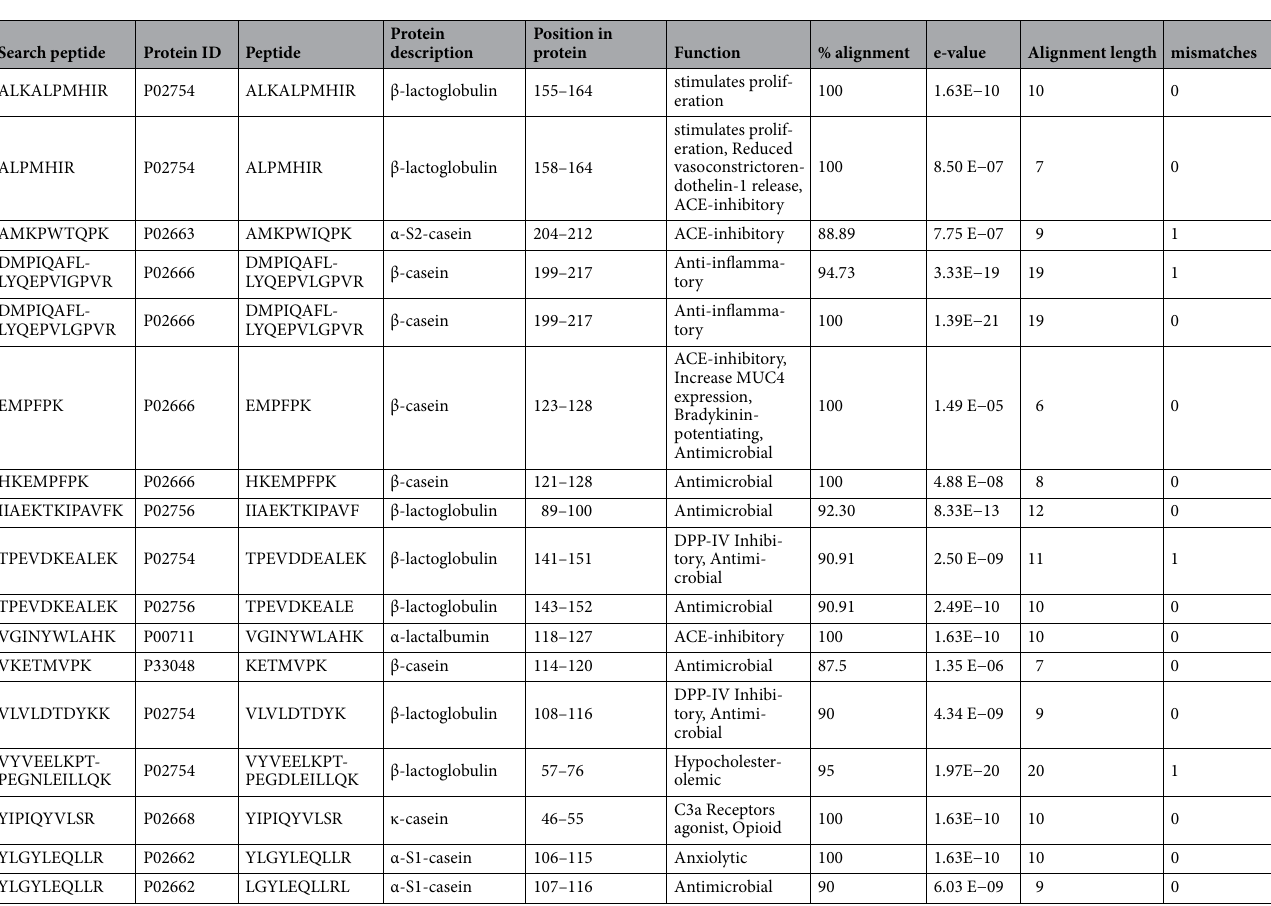
Table 5. The function of identified bioactive peptide from